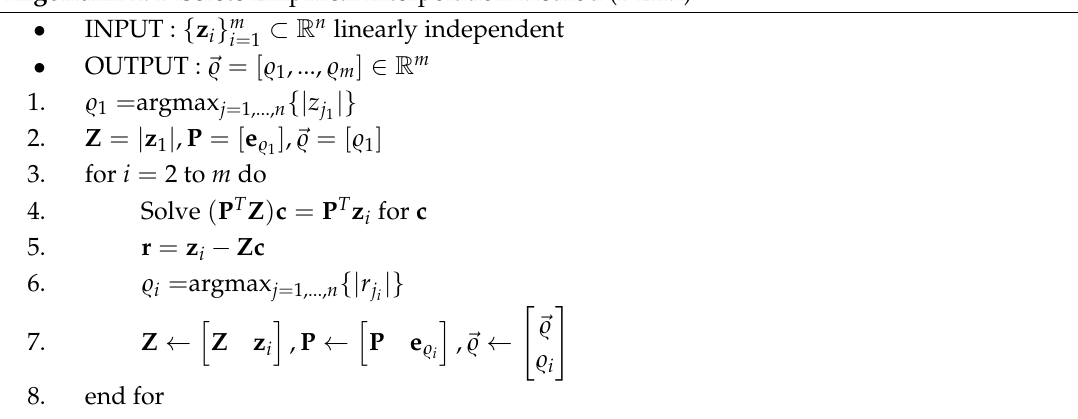
Algorithm 2: Discrete Empirical Interpolation Method